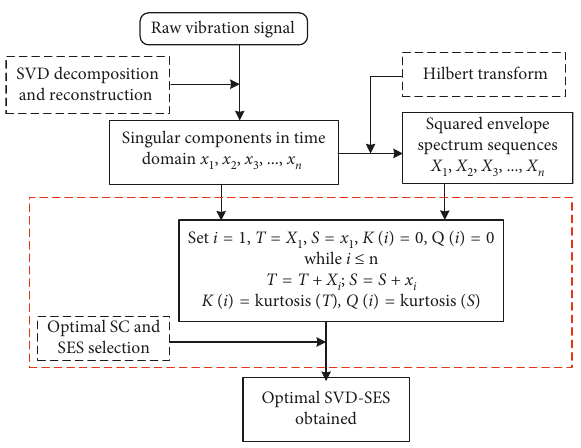
Figure 1: The SVD-KSES flowchart to select optimal